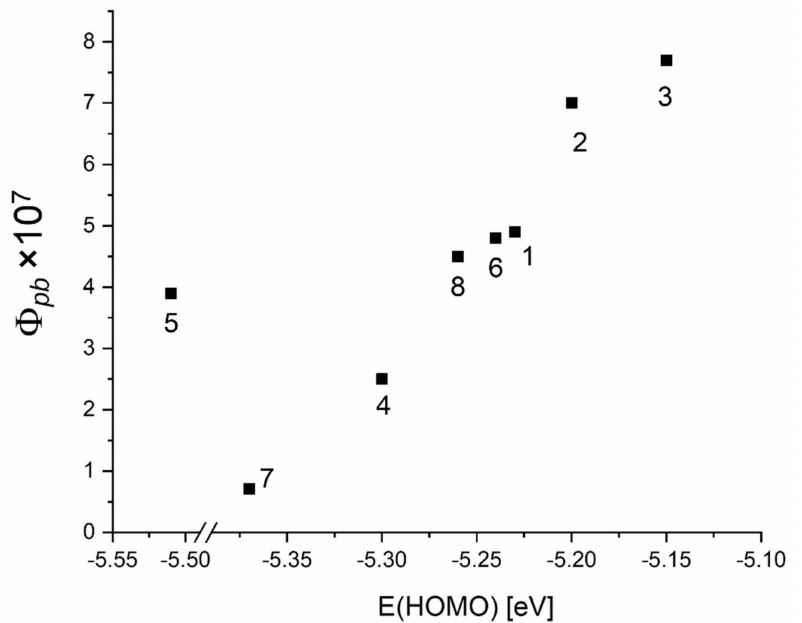
Figure 4. Correlation between the observed photobleaching quantum yields and the calculated highest occupied molecular orbital (HOMO)